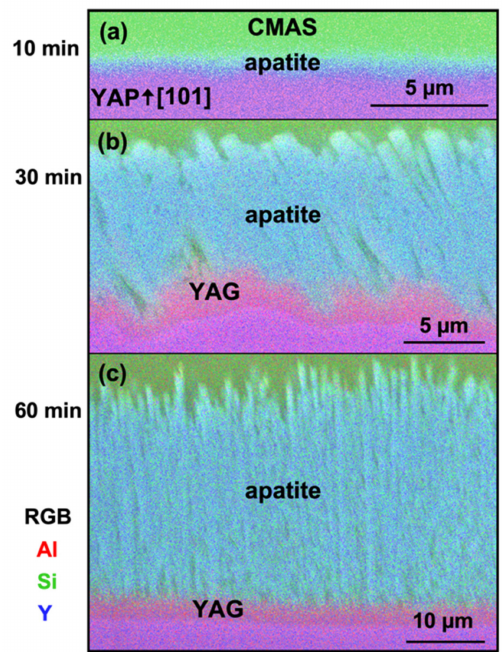
Figure 6. EDS maps showing the qualitative phase compositions at the (101) YAP/CMAS interface at ( a ) 10, ( b ) 30, and ( c ) 60 min exposure at 1350 ◦ C. These maps combine the Al, Si, and Y EDS signals, represented in red (R), green (G), and blue (B),